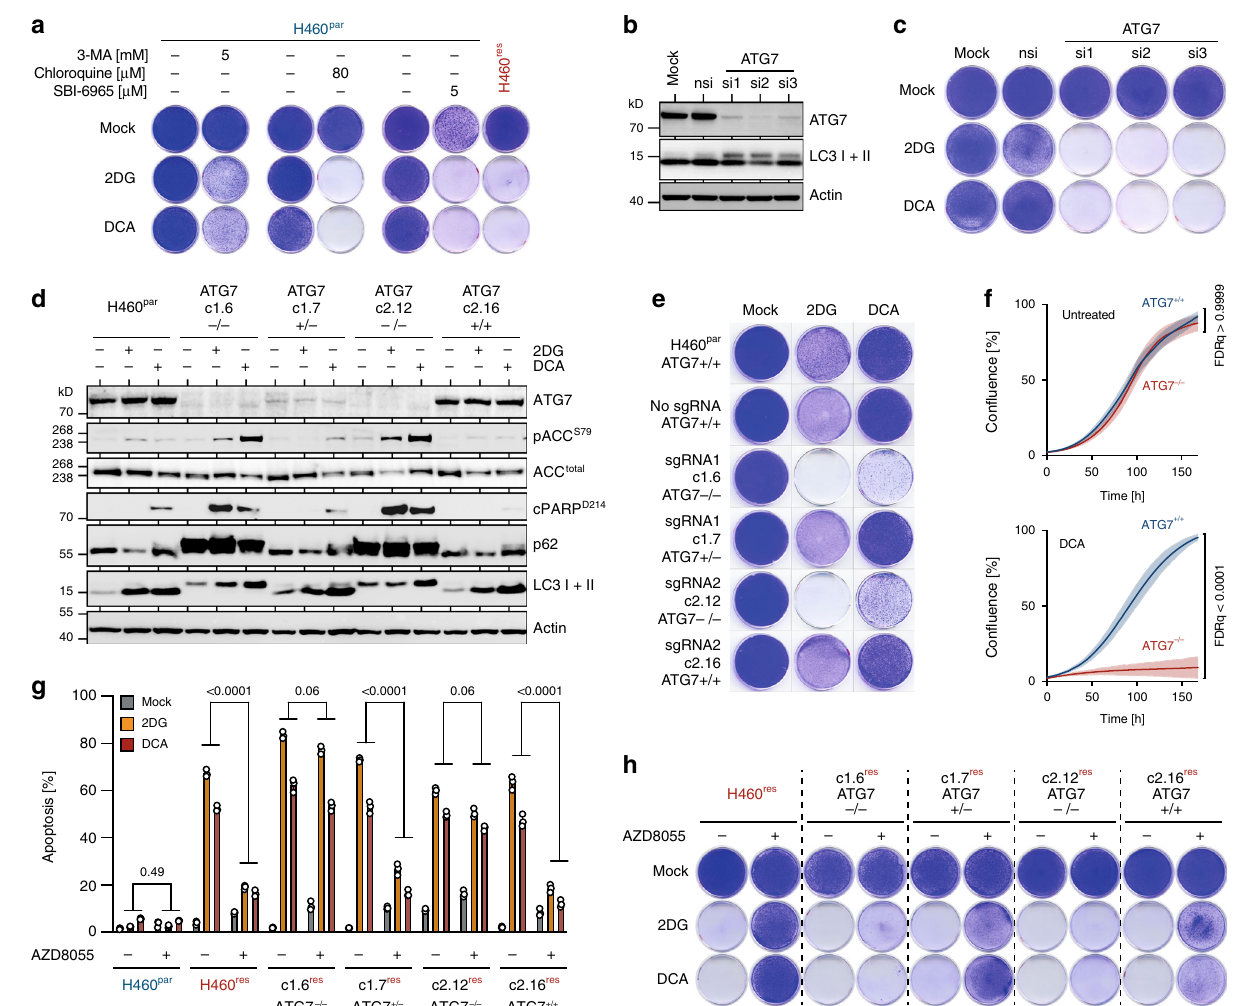
Fig. 4 Suppression of autophagy by mTOR sensitizes to 2DG/DCA. a Clonogenic growth assay. H460 par cells were pre-treated with 3-methyladenine (3-MA), chloroquine or ULK inhibitor SBI-0206965 for 48 hours before adding 2DG/DCA. H460 res cells are shown as control. b , c H460 par cells were transfected with a control siRNA (nsi) or siRNAs targeting ATG7. b Western blot. c Clonogenic growth under 2DG/DCA treatment. d – f H460 par subclones with indicated CRISPR-engineered ATG7 mutations were analyzed for mTOR signaling, autophagy markers and response to 2DG/DCA treatment. d , Western blot. e , Clonogenic growth. f , Proliferation curves determined by real-time live-cell imaging. Shown is cell culture con fl uence as mean ± SD, n = 3, FDR q values. g , h H460 par clones with CRISPR-induced ATG7 indel mutations were made CDDP-resistant by dose escalation and tested for mTOR- dependent response to 2DG/DCA treatment. g , Flow cytometry analysis for apoptosis (sub-G1). Shown are mean ± SD, n = 3, FDR q values. h Clonogenic growth of CDDP-resistant H460 cells with indicated ATG7 genotype treated with 2DG/DCA ± AZD8055. Shown are representative